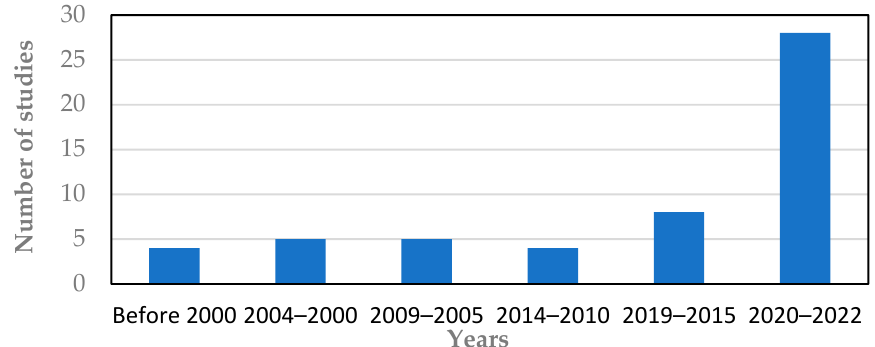
Figure 4. Number of published ML ‐ related studies with wind engineering applications.